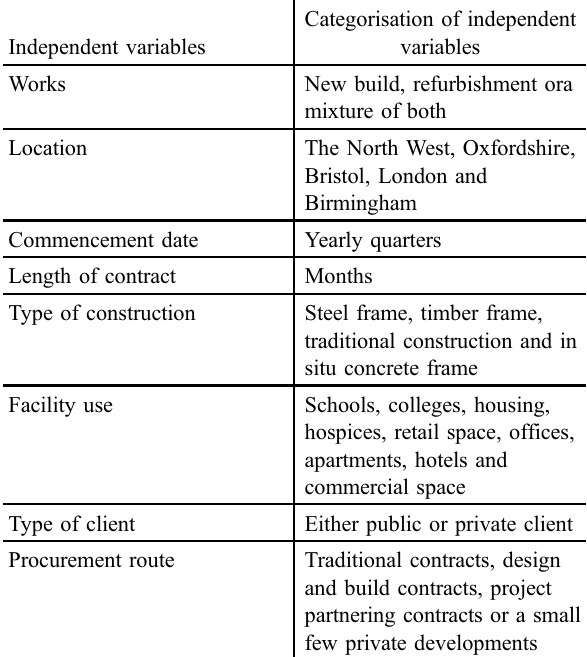
Table 1. Independent variables and their